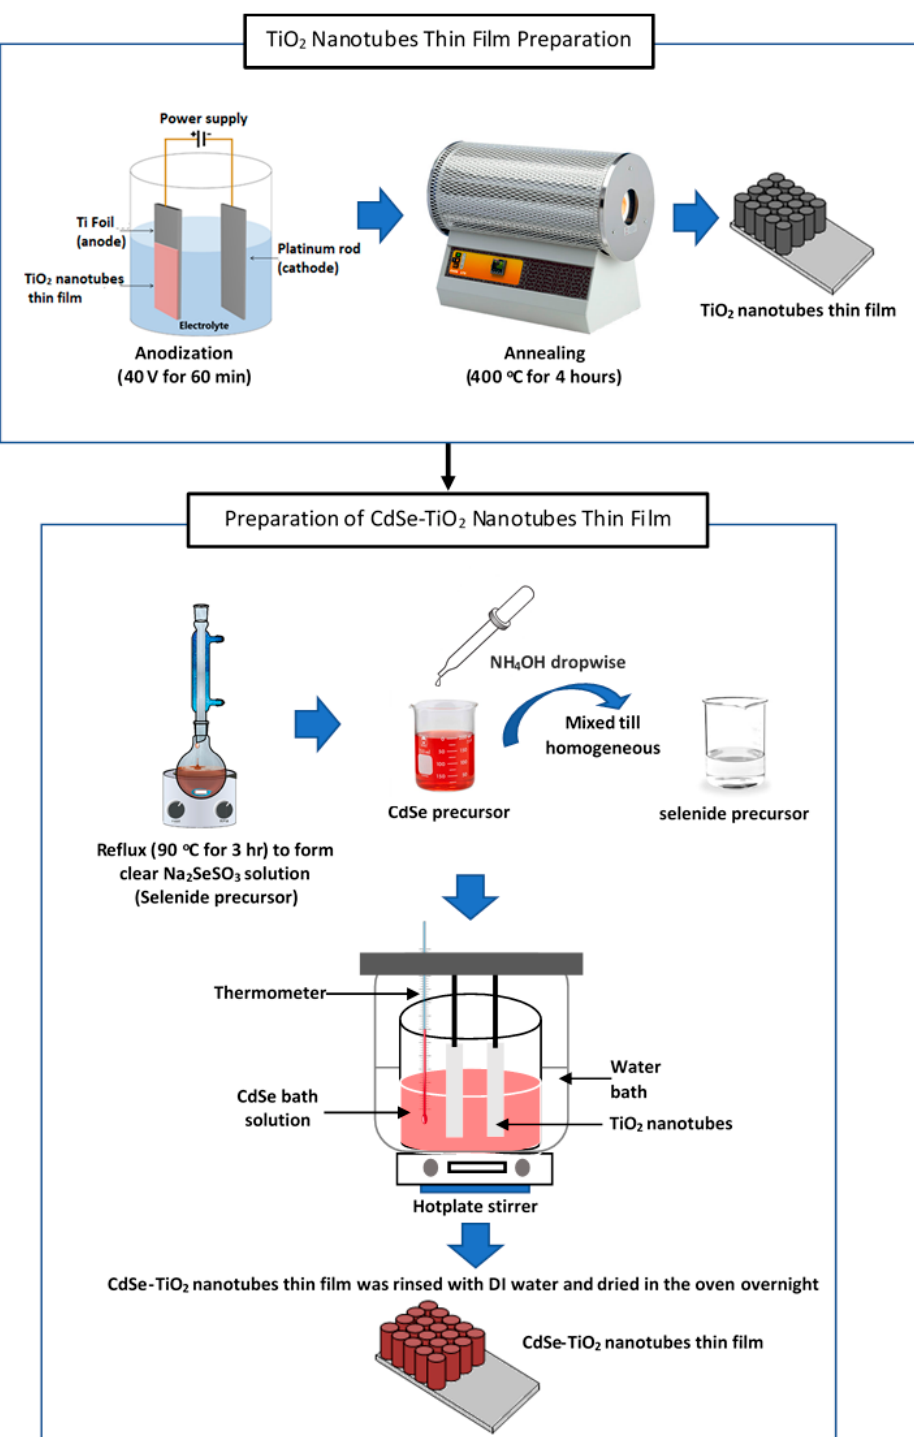
Figure 1. Schematic diagram of the preparation of TiO 2 nanotube thin films and CdSe–TiO 2 nanotube thin films.